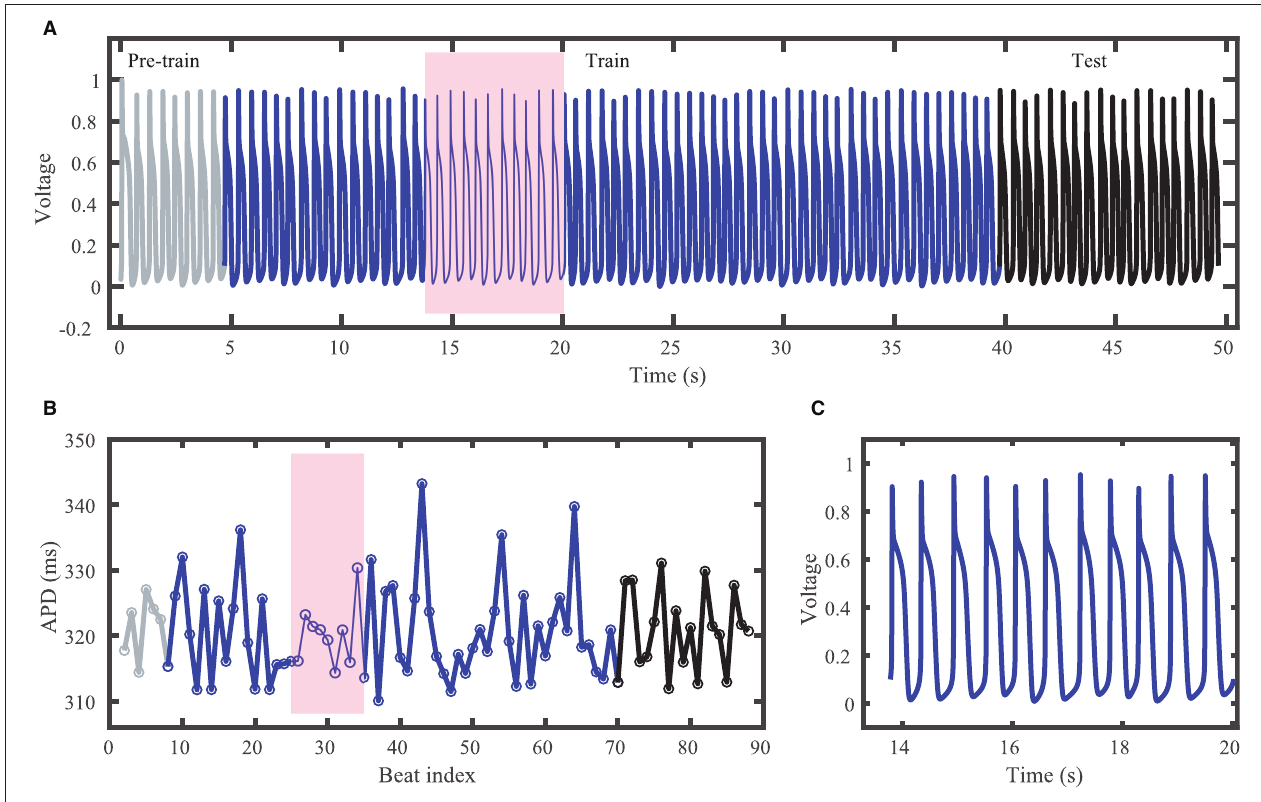
FIGURE 2 | Synthetic action potential time series generated by the Noble model driven by the chaotic Lorenz model. (A) Voltage time series including unused pre-training data (gray), training data (blue), and testing (prediction) data (black). (B) Corresponding APDs, following the same color scheme as (A) . (C) Zoomed in voltage trace corresponding to the shaded region in (A,B) showing the irregular action potential shapes and